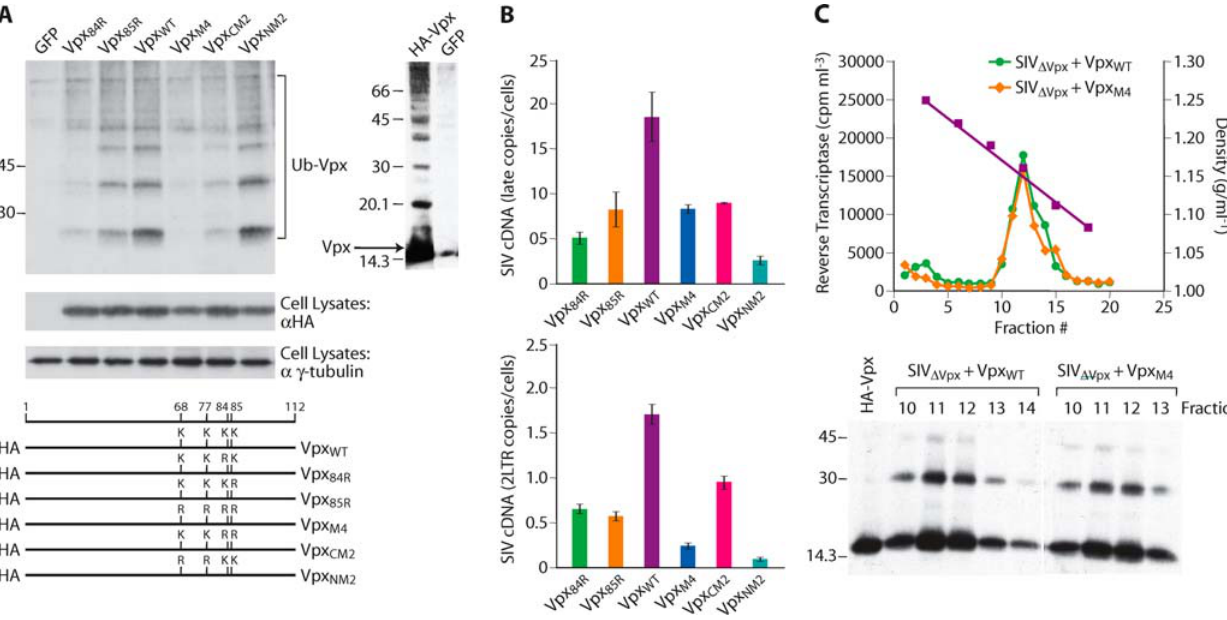
Figure 3. Role of the proteasome ubiquitylation system in regulation of SIV infectivity by Vpx. ( A) Identification of ubiquitylated residues in Vpx. Wild type and lysine mutant Vpx proteins (HA tag) were expressed in 293T cells expressing Histidine-tagged ubiquitin. ( B) Susceptibility of primary macrophages to infection by SIV D vpx packaging either wild type Vpx or lysine substitution mutants of Vpx. Vpx proteins were packaged after co-transfection of SIV D vpx proviral DNA with plasmids expressing wild or lysine mutant Vpx proteins or GFP as a control. Virus infection was gauged from quantitation of late viral cDNAs and 2-LTR cDNAs 48 h post infection (error bars are s.d. of 3 replicate measures of a single DNA sample). (C) Packaging of wild type and non-ubiquitylated Vpx proteins in virus particles (upper panel). The presence of Vpx in gradient purified virions was determined by Western blotting with an HA antibody (lower panel).